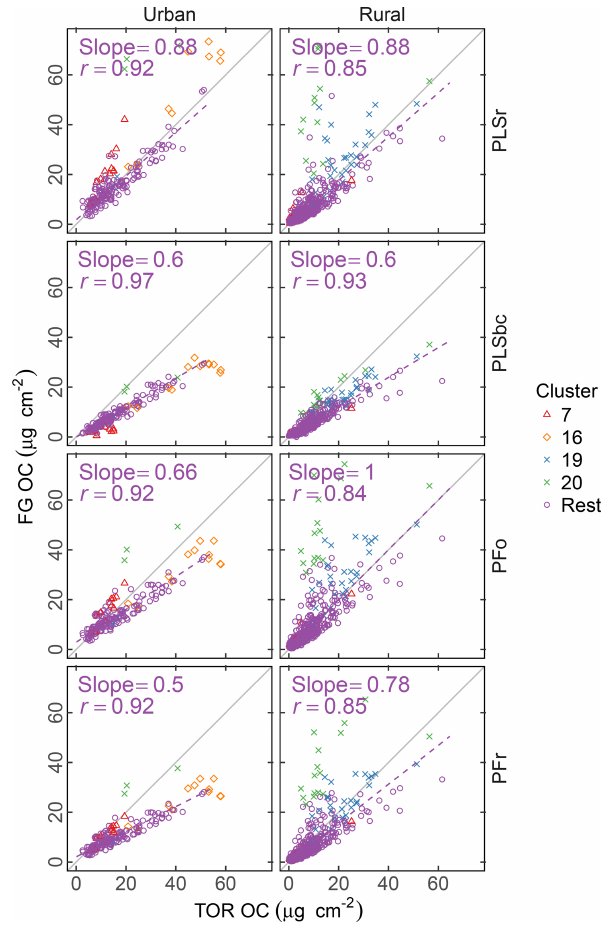
Figure 4. Comparison of estimated OC (FG OC) against OC mea- sured by TOR method (TOR OC). PFo refers to peak fitting us- ing the original parameters. PLSr refers to partial least square using raw spectra. PFr refers to peak fitting using the recalibrated absorp- tion coefficients. PLSbc refers to partial least square using baseline- corrected spectra.